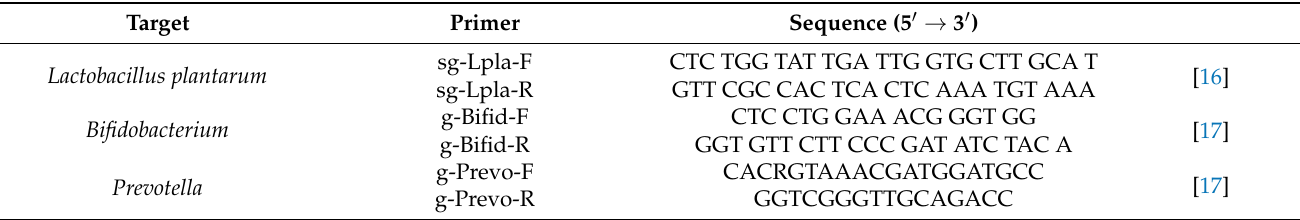
Table 1. Specific primers used in the